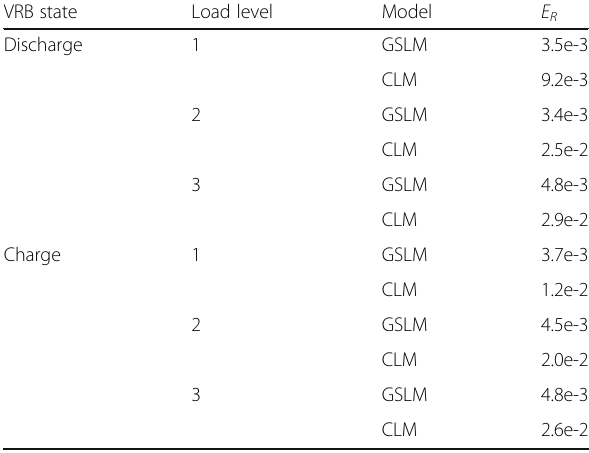
Table 6 Error comparison of GSLM and CLM